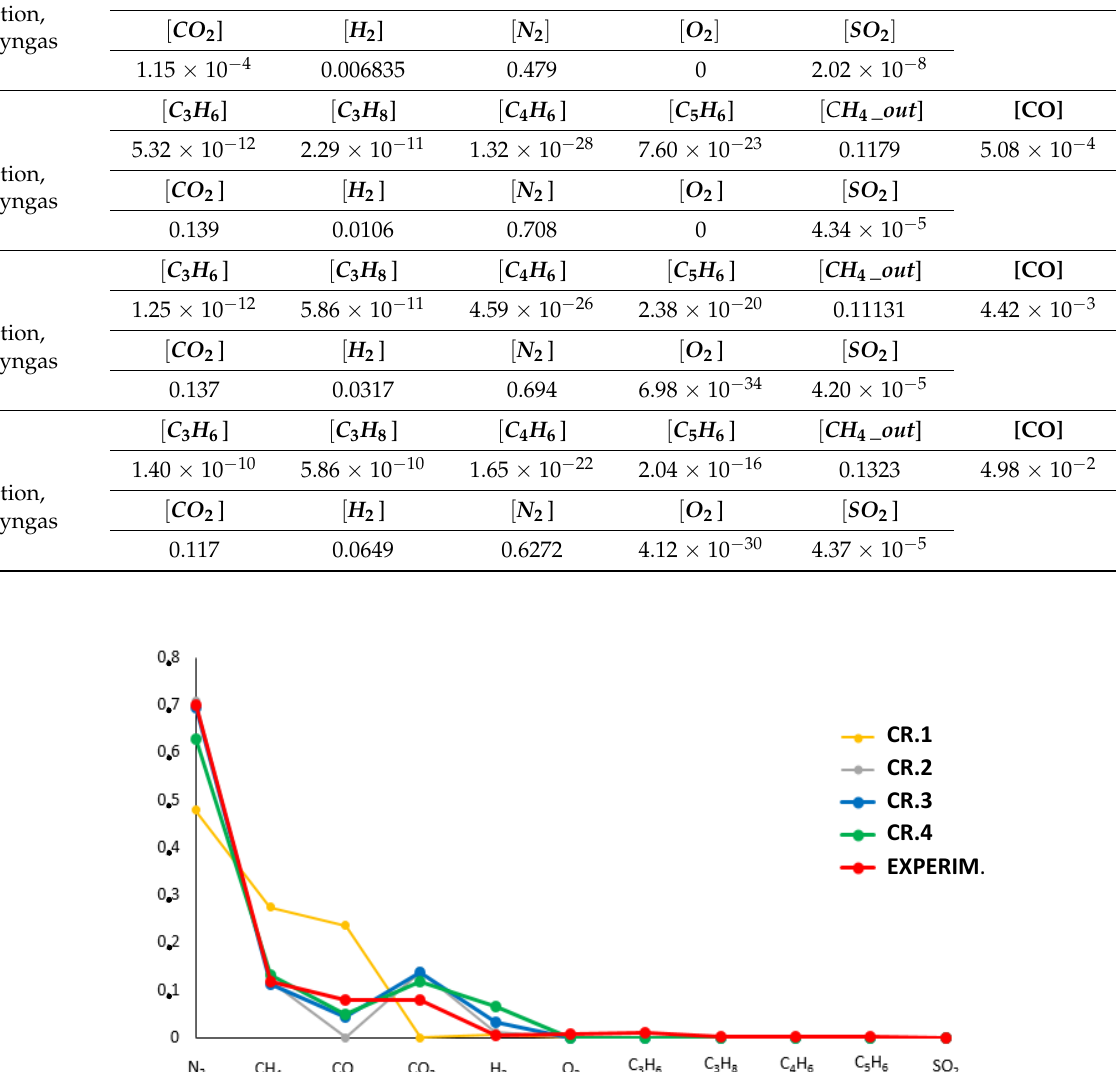
Table 9. Syngas combustible species and reference LHV values adopted for the LHV calculation.